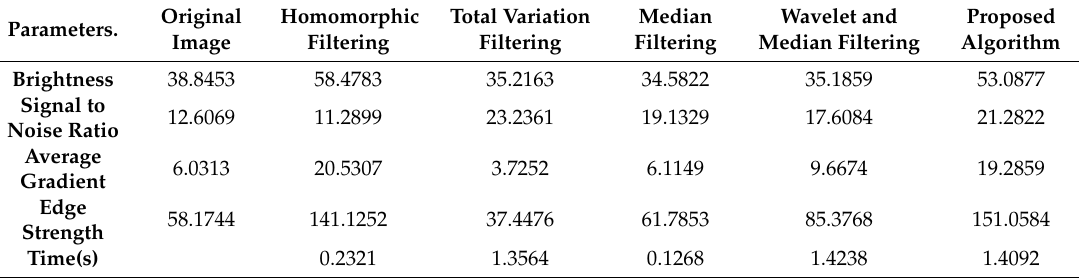
Table 3. Comparison of performance indicators of different algorithms.